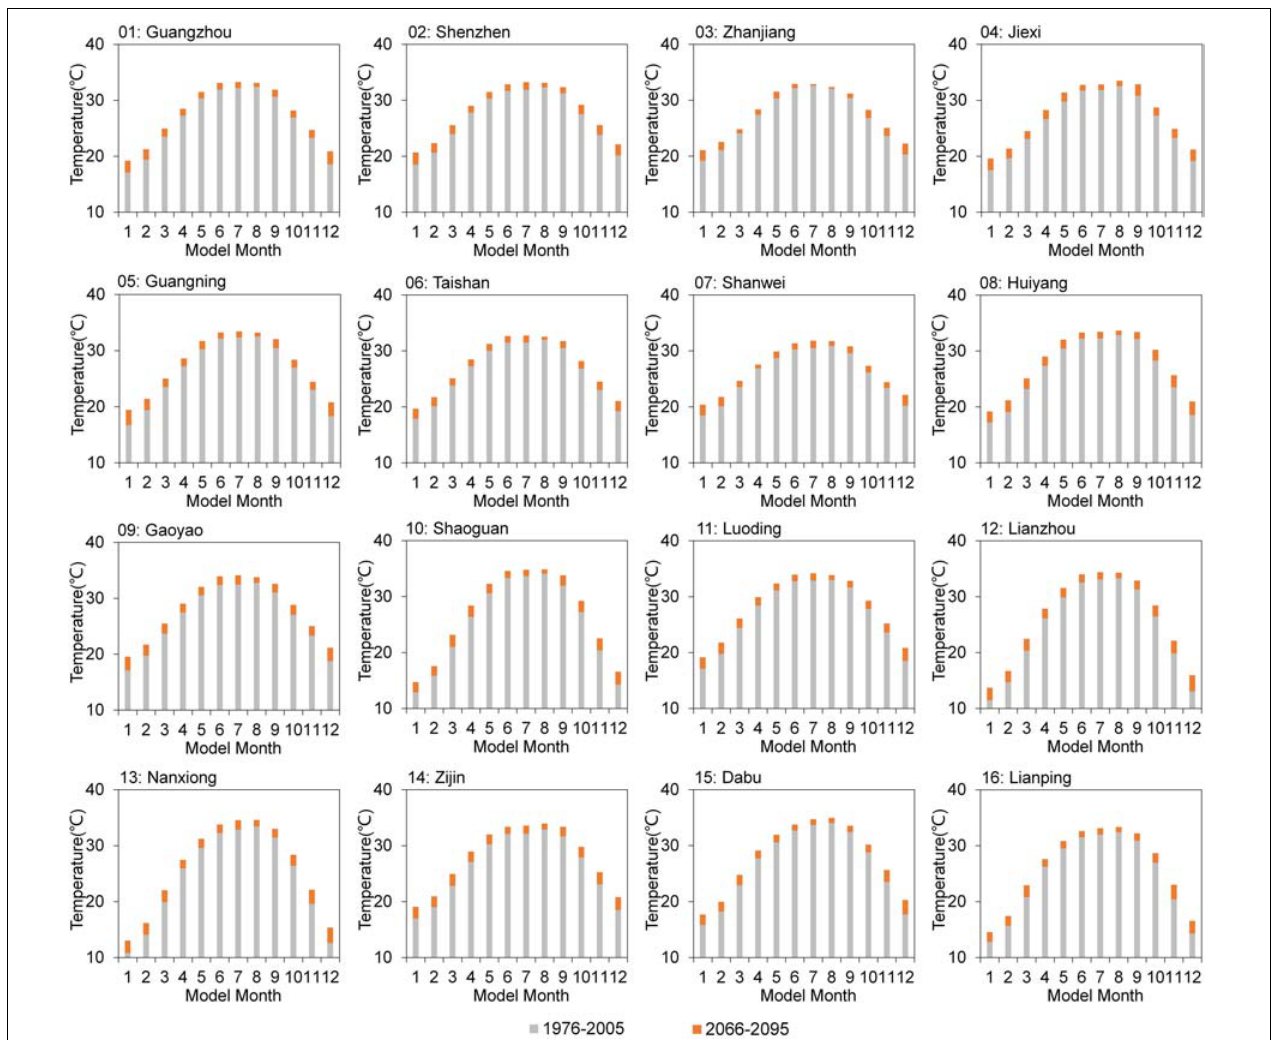
FIGURE 9 | Projected monthly variations of Tmax between 2066–2095 and 1976–2005 under